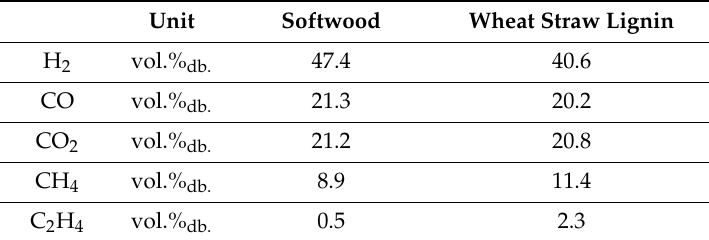
Table 2. Composition of product gas in volume percentage (vol.% db. ) from the experiments with softwood and wheat straw lignin in the 100 kW DFB gasification pilot plant [23].